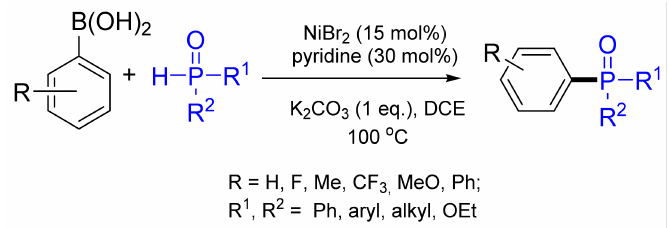
Figure 20. Nickel-catalyzed coupling of arylboronic acids with P -nucleophiles.